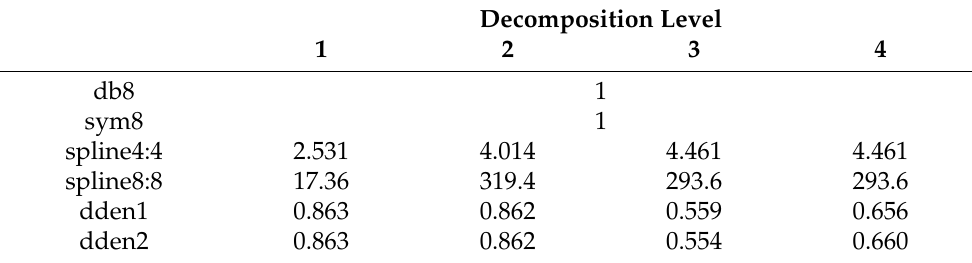
Table 1. Values of the uncertainty transfer coefficient k i of the Discrete Wavelet Transform (DTW) algorithm depending on the type of wavelet and the number of decomposition levels for errors which have normal distribution.